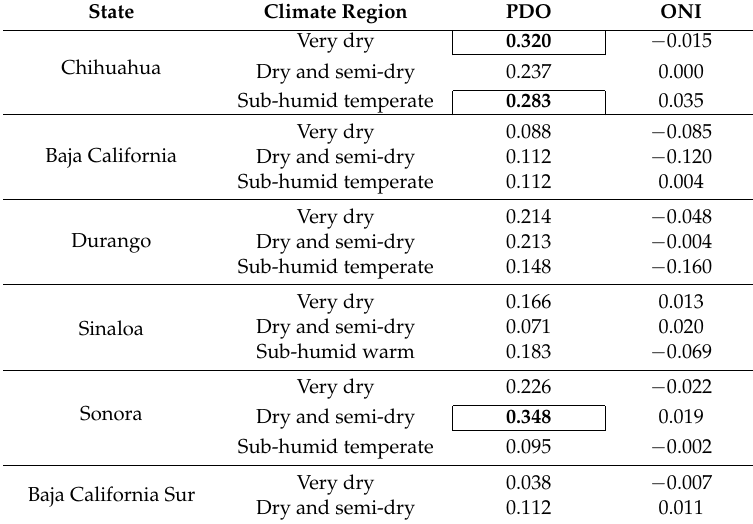
Table 7. Correlation analysis for SPEI-24, PDO and ONI in the period 1952–2013 in northern Mexico. Source: Authors, following INEGI climatic classification, 2018 (http://www.cuentame. inegi.org.mx/monografias/) and the databases (http://sac.csic.es/spei/, https://www.ncdc.noaa. gov/teleconnections/pdo/ and http://origin.cpc.ncep.noaa.gov/products/analysis_monitoring/